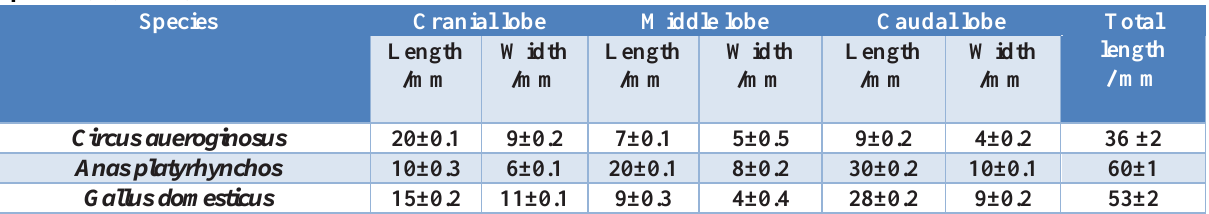
Table, 1: illustrated the measurements of kidneys’ lobes and their total lengths (n=5 in each species)